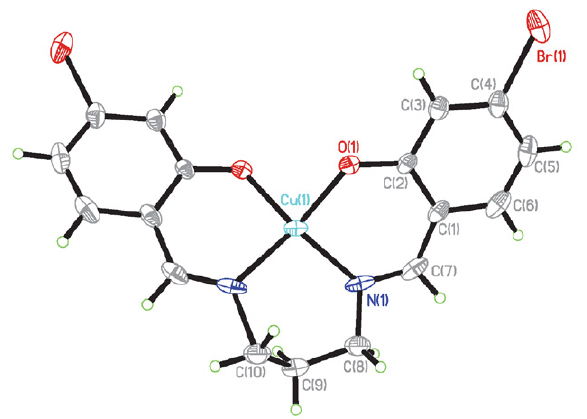
Fig. 1. A perspective view of the molecular structure of complex 1 with the atom labeling scheme. Thermal ellipsoids are drawn at the 30% probability level.